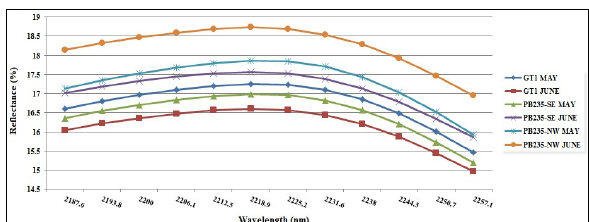
Figure 18. Spectral behaviour in leaf scale in the region 2,220nm of the Rubber trees stands: GT1, PB235-SE and PB235-NW